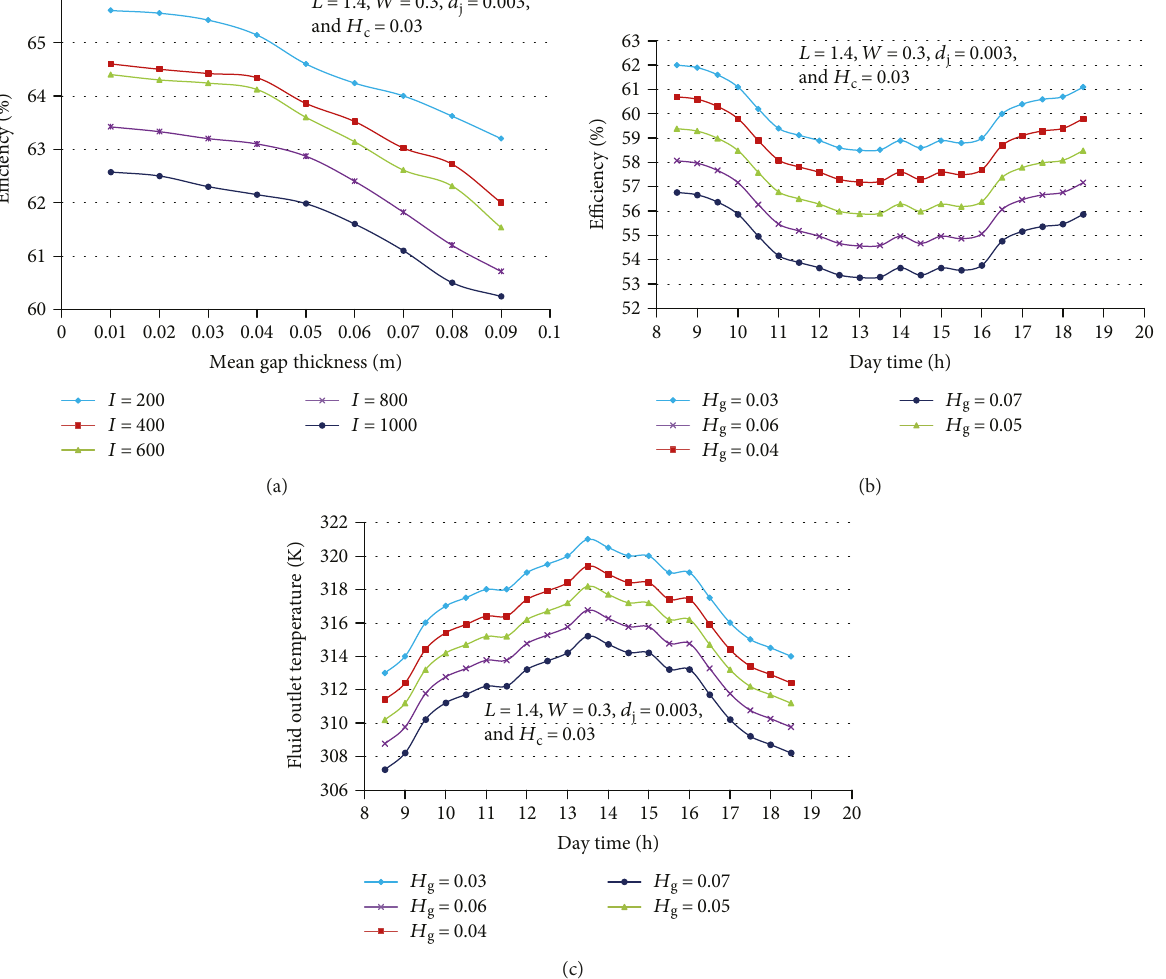
Figure 22: Prediction of the optimum mean gap thickness between the absorber plate and the jet plate ( H (a) SAH e ffi ciency versus H at di ff erent solar radiation levels. (b) Hourly SAH e ffi ciency over daytime at di ff erent H g temperature at di ff erent H g